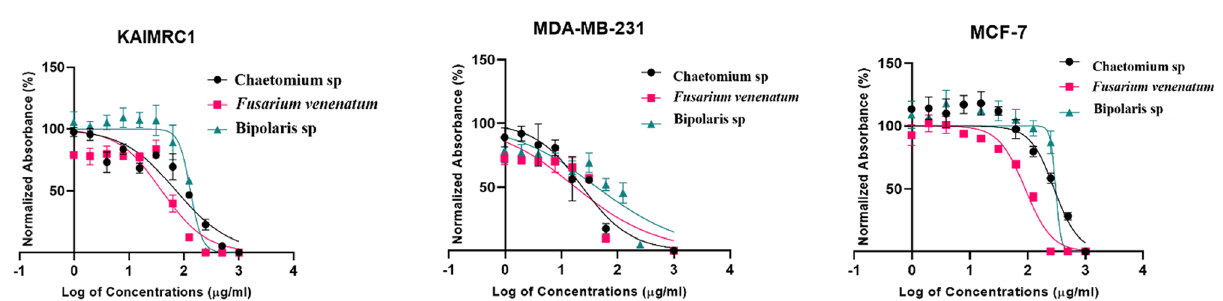
Figure 4. Dose–response manner and the inhibition curve of the three tested crude extracts on different breast carcinoma